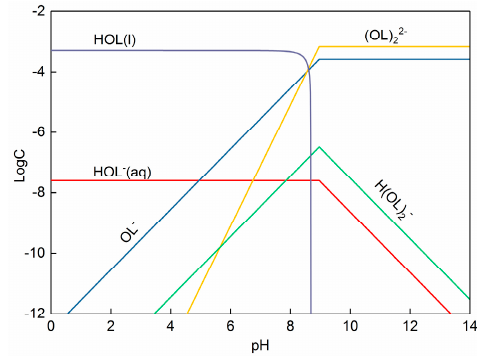
Figure 12. Species distribution diagram of sodium oleate as a function of pH, (NaOL: 5 × 10 − 5 mol/dm 3 ).